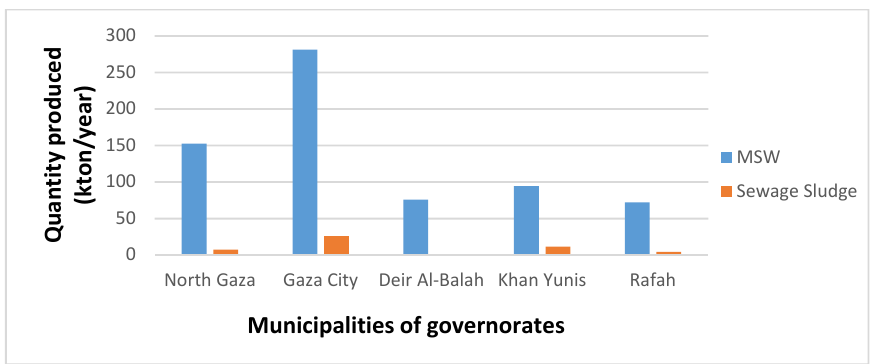
Figure 6. Solid municipal waste and wastewater sludge generated in each governorate.